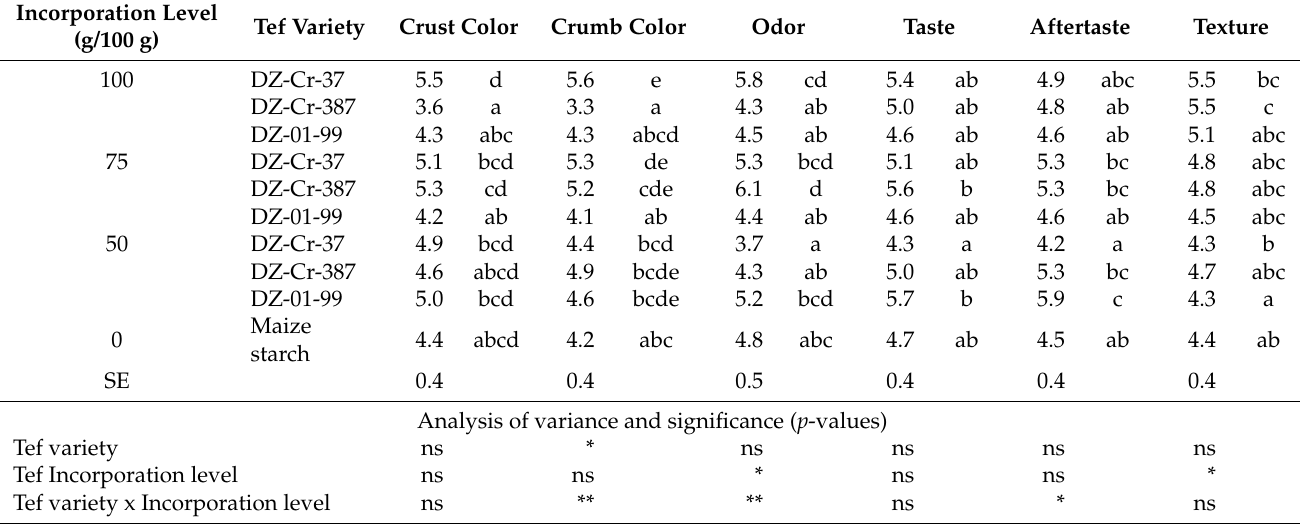
Table 2. Effect of tef incorporation level and variety type on the sensory parameters of GF